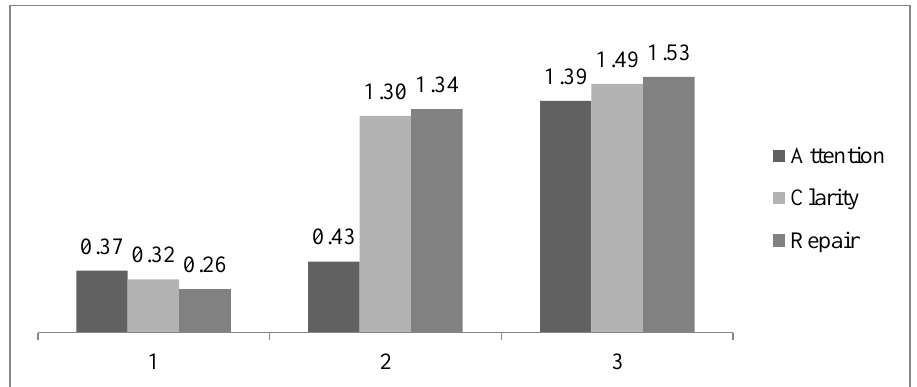
Figure 1. Representation of the three-cluster model: Group 1: LGEI (low general emotional intelligence (EI) scores), Group 2: HR–HC–LA (high repair, high clarity and low attention scores), and Group 3: HGEI (high general EI scores).